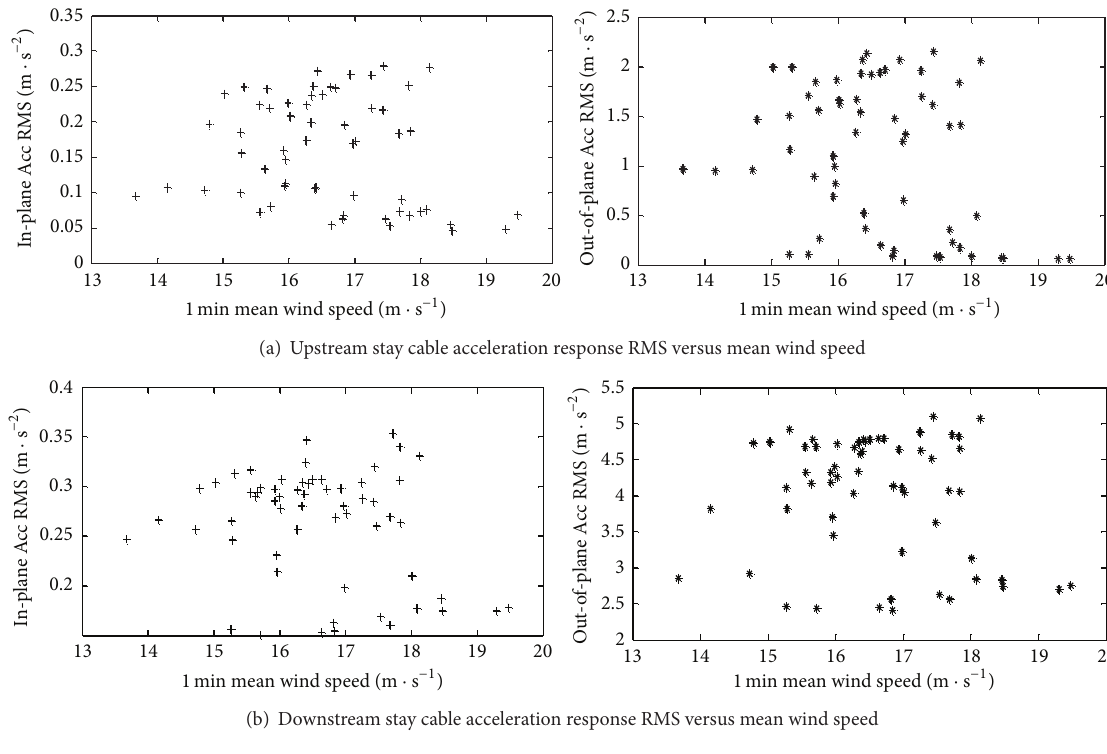
Figure 18: Acceleration response RMS of stay cable versus mean wind speed.